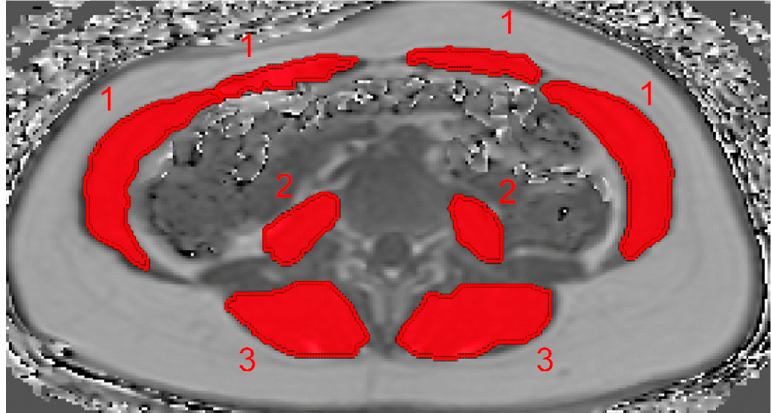
Figure 1. Representative segmentation of the abdominal muscles, psoas muscle, and erector spinae muscle in the proton density fat fraction (PDFF) map of a 40-year-old woman. The rectus abdominis muscle and internal oblique muscle (1), psoas muscle (2), and erector spinae (3) are segmented at the level of L4.